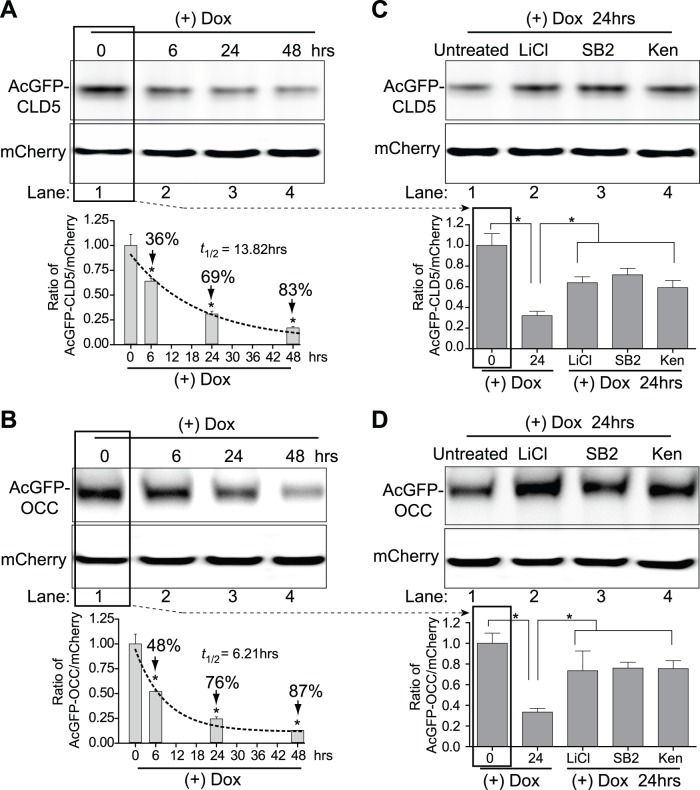
GSK3β inhibition regulates occludin and claudin-5 stability in BMVEC.BMVEC were transfected with the tight junction stability system for 24 hr and 200 ng/ml of doxycycline (Dox) was added for 6, 24 or 48 hr. Panels A and B: Basal protein turnover of AcGFP fused claudin-5 (A) and occludin (B) was evaluated by western blots probed for GFP. Graphed results from densitometric analysis are shown along with protein half-life determinations using first order kinetics (dashed line). The values are expressed as the mean ± SEM (n = 3) of the normalized densitometry ratio of the fused protein to that of co-expressed reference protein mCherry. (C and D) Show the effect of GSK3β inhibitors on claudin-5 (C) and occludin (D) protein turn-over at 24 hrs using the tight junction protein stability system. The untreated controls display the marked reduction in tight junction protein at 24 hrs while those with GSK3β inhibitors significantly attenuate this effect. The graphed densitometry values were calculated using the ratio of AcGFP to mCherry and normalized to fold change. Note: the densitometry shows the time zero reference which is not shown in the blots (see A and B). The results are shown as the mean ± SEM (n = 3), (*) denotes a difference of P<0.05 between the groups compared (bracket).